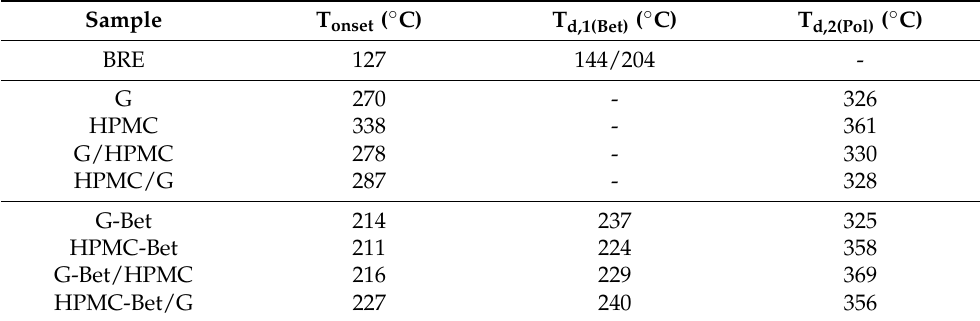
Table 3. TGA parameters of lyophilized beetroot extract (BRE), control, and active capsules.